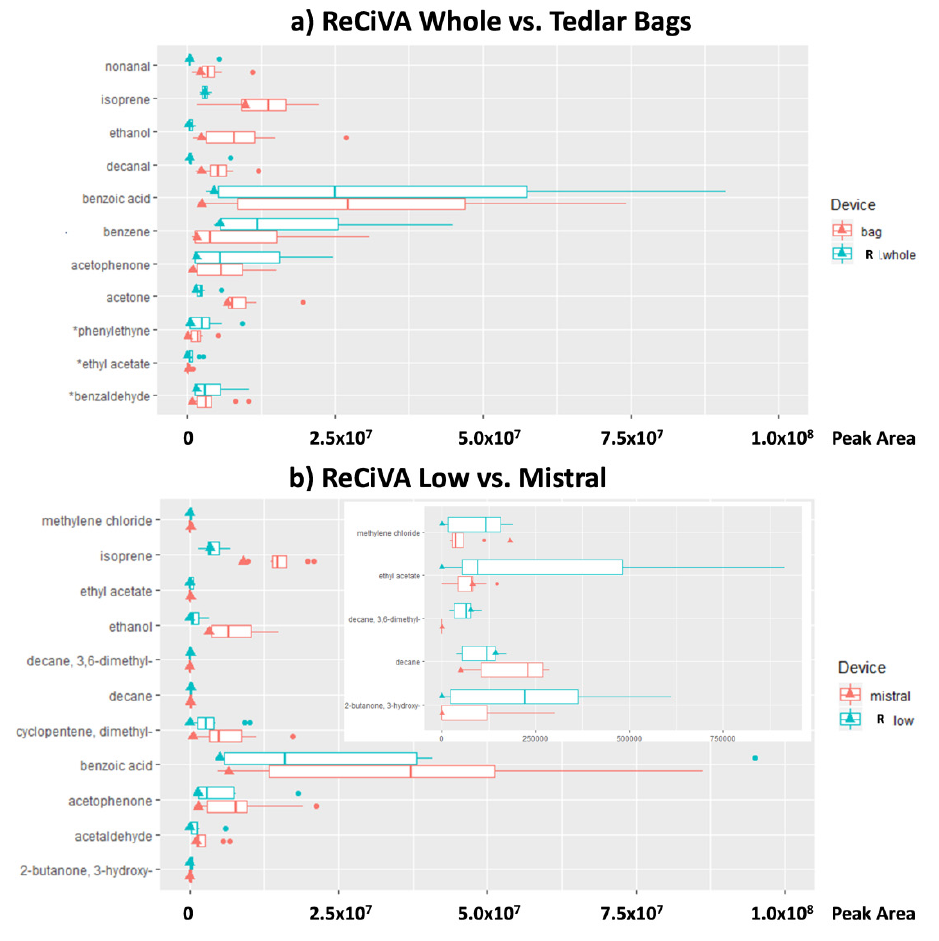
Figure 5. Comparison between a normalized peak area of VOCs significantly different at the 95% and 90% of significance, respectively, in an alveolar fraction of exhaled breath samples collected by using a Mistral and ReCIVA Low approach ( a ) and in whole expiratory breath samples collected by using Tedlar bags and a ReCIVA Whole approach ( b ). The triangle represents a result related to the only one breath sample collected from a patient affected by lung cancer (LC).